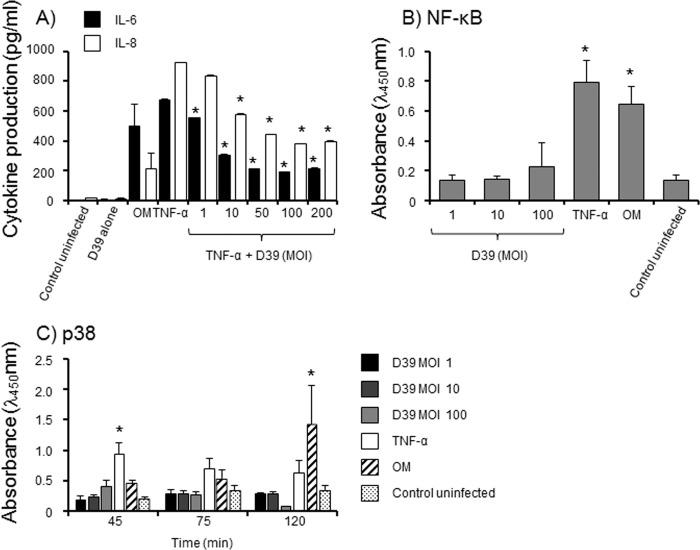
Inflammatory cytokine responses of Met-5A PMC.A) Met-5A cell monolayers (n = 3 wells) were infected in triplicate wells with live D39 (MOI 1–200), stimulated with pure TNF-α (100ng/ml) or Nm-OM (100ng/ml) and also pre-stimulated with TNF-α (100ng/ml) for 4h and then infected with various MOI (1–200) of live D39. Control cells were left with medium alone. Cells were also treated with live D39 without any other stimulation (no cytokine production at any of the concentrations tested between MOI 1–200). After 24h, supernatants were removed and production of IL-6 and IL-8 quantified by ELISA. The bars represent mean cytokine levels and the errors bars the standard deviation from triplicate wells from a representative experiment (n = 2). * denotes statistically significant reduction in IL-6 or IL-8 compared to cells treated with TNFα only (p<0.05). B) Met-5A cells were challenged in triplicate wells with live D39 bacteria (1–100 MOI), TNFα (30 ng/monolayer) or Nm-OM (30ng/monolayer). At intervals up to 2h, cells were processed and NFkB p65 protein measured by ELISA. The columns and symbols denote the mean absorbance readings from n = 3 experiments and the error bars the standard errors of the mean. * denotes statistically significant increase compared to control cells (p<0.05). C) Met-5A cells were challenged in triplicate wells with live D39 bacteria (1–100 MOI), TNFα (30 ng/monolayer) or Nm-OM (30ng/monolayer). At intervals up to 2h, cells were processed and p38 MAP Kinase protein measured by ELISA. The columns and symbols denote the mean absorbance readings from n = 3 experiments and the error bars the standard errors of the mean. * denotes statistically significant increase compared to control cells (p<0.05).